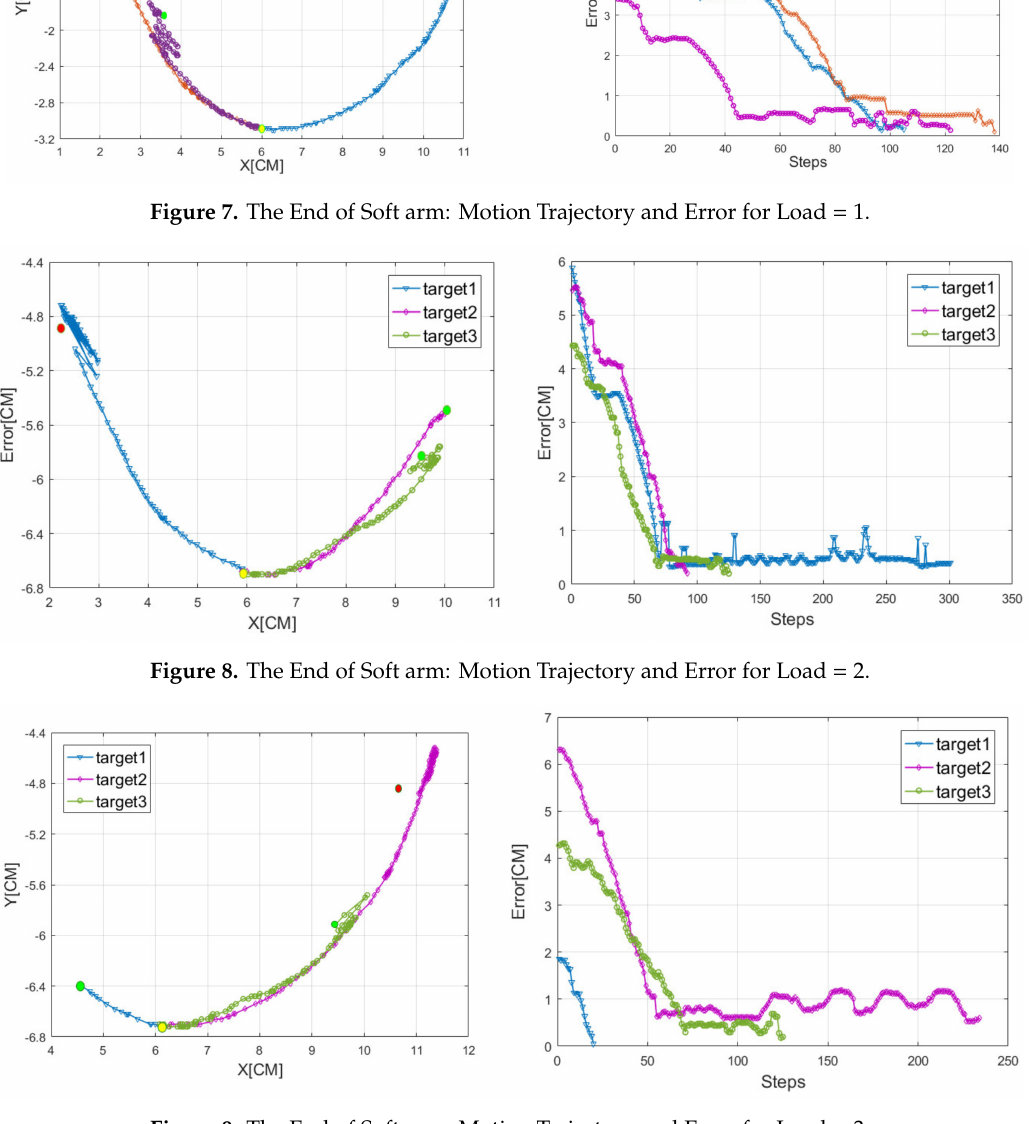
Figure 9. The End of Soft arm: Motion Trajectory and Error for Load =